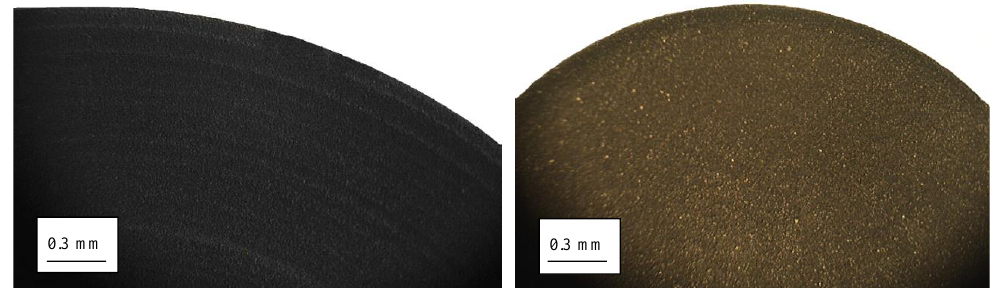
Figure 9. The difference between the graphite electrode before and after being used.